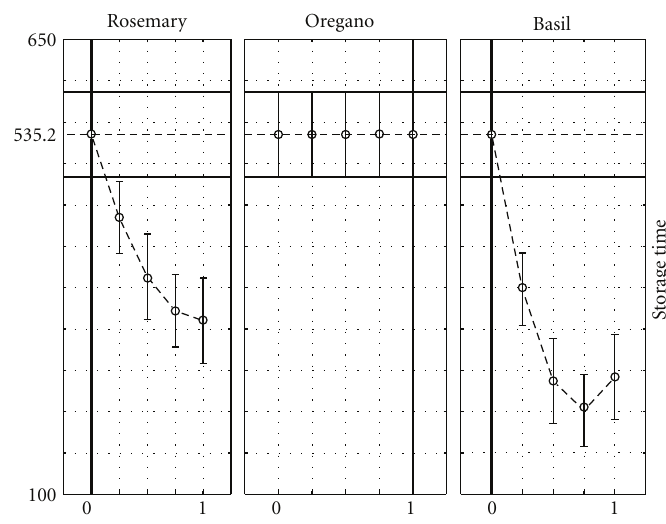
F 5: �ptimum conditions pro�le for studied variables according to accelerated stove